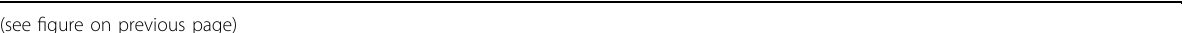
Fig. 5 The effect of the miR-320a inhibitor on CTNNB1 was suppressed by DANCR overexpression. a Relative expression levels of DANCR and miR-320a were measured by qRT-PCR when DANCR was overexpressed or silenced. b Relative expression levels of DANCR, miR-320a, and CTNNB1 were detected by qRT-PCR. ( c ) Western blot analysis was performed to determine the protein expression of CTNNB1 ( β -catenin). d Quantitative analysis of β -catenin protein expression in c . e The binding sites of CTNNB1 with DANCR or miR-320a were predicted using LncRNA2Target v2.0 and RNA Interactome Database web tools. f A luciferase reporter assay was performed to con fi rm the binding of CTNNB1 with DANCR and miR-320a. CTNNB1-WT and CTNNB1-MUT were cloned into a luciferase reporter vector, and BMSCs were cotransfected with lentivirus encoding miR-320a inhibitor, DANCR overexpression or knockdown vectors. g BMSCs were transfected with pcDNA3.1-DANCR, miR-320a mimic-carrying lentivirus or negative controls. β -Catenin protein expression was determined by western blot. h Relative luciferase activity of CTNNB1-WT and CTNNB1-MUT was